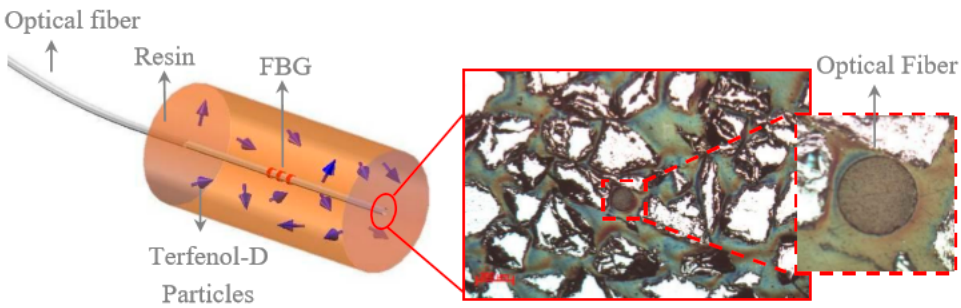
Figure 15. Preparation process of magnetostrictive composites.